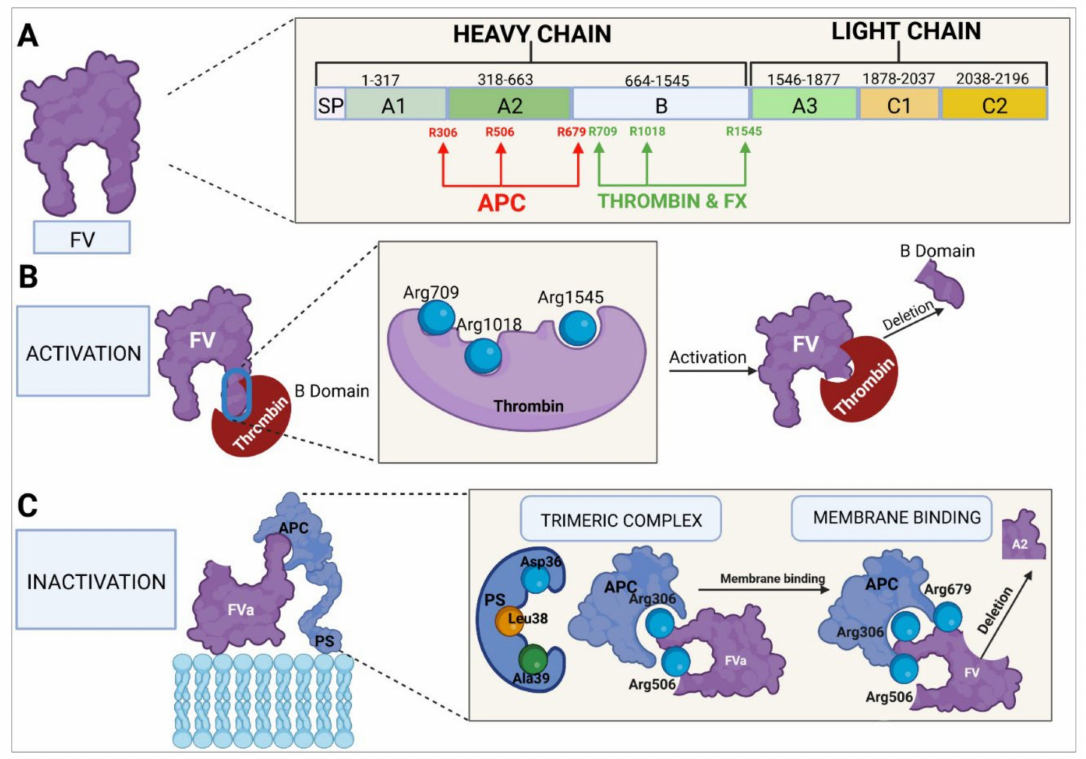
Figure 5. Molecular characteristics of factor V. ( A ) Domain-based structure of the protein, sites at which it interacts with other factors and cofactors, and activation and inactivation sites. ( B ) Thrombin- mediated activation and B domain deletion. ( C ) Inactivation by APC and PS, in conjunction with phospholipids on the membrane of vascular endothelial cells or platelets; deletion of the A2 domain. FV, factor V; FX, factor X; APC, activated protein C; PS, protein